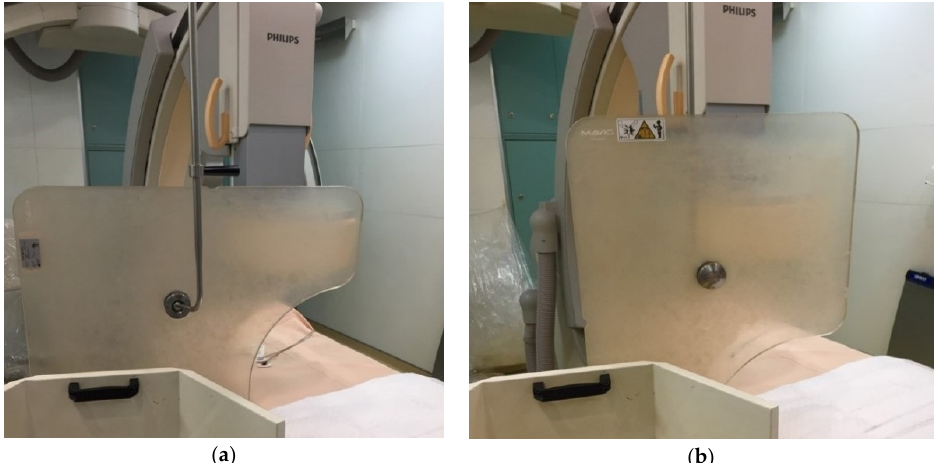
Figure 2. Placement of the ceiling-mounted lead glass shield: ( a ) horizontal placement; ( b ) vertical placement. Table 1. Summary of geometrical configuration for radiation dose